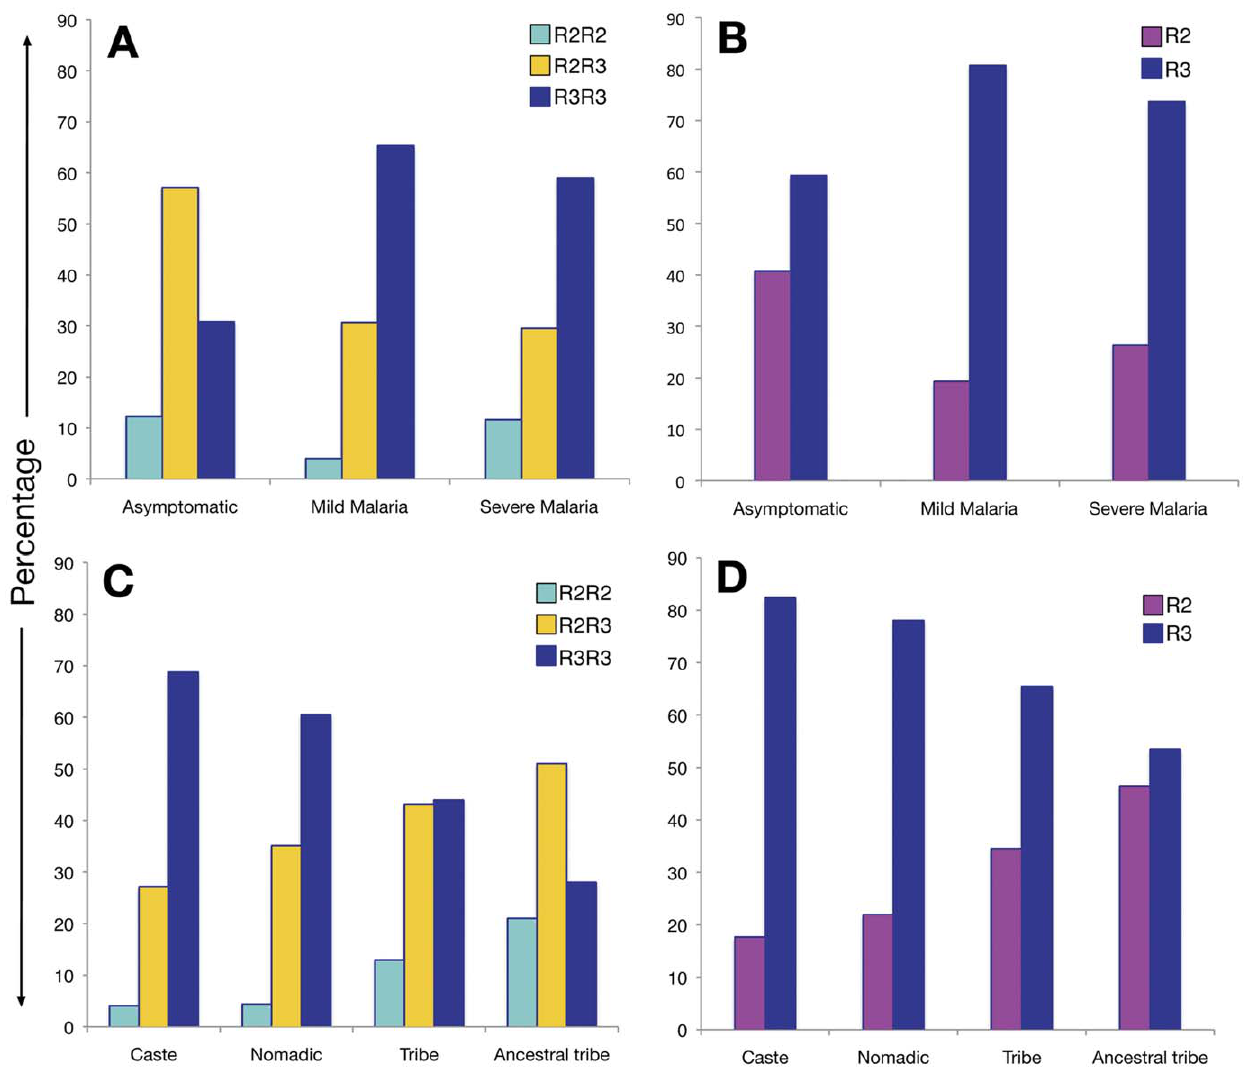
Figure 1. Distribution of IL-4 intron-3 VNTR polymorphism. A and B: genotype and allelic distribution between malaria case control groups, respectively; C and D: genotype and allelic distribution among caste, nomadic, tribe and ancestral tribe, respectively.